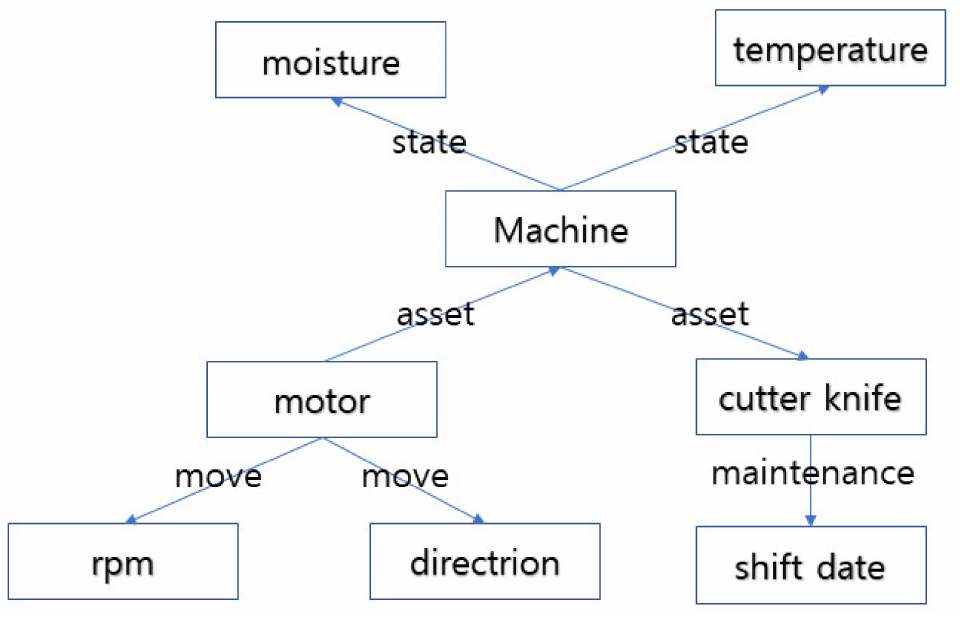
Figure 7. Example of a facility-oriented semantic expansion.